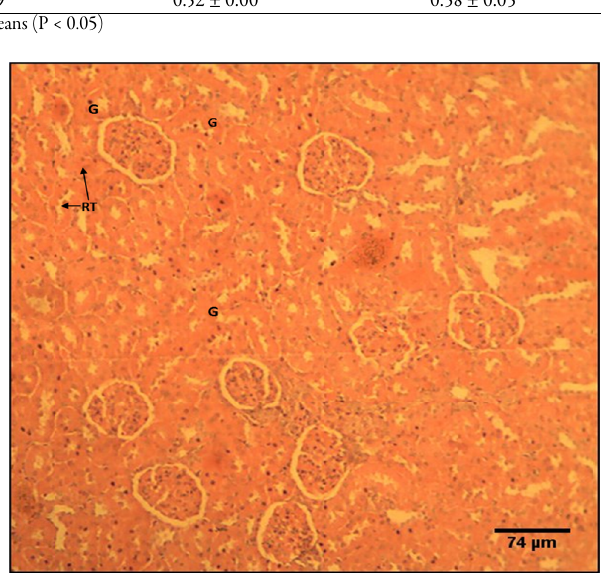
Fig. 1. Histological appearance of liver of rat given 200 1. Histological appearance of liver of rat given 200 1. Histological appearance of liver of rat given 200 body weight of methanol fruit extract of body weight of methanol fruit extract of body weight of methanol fruit extract of Piper guineense for 28 days, showing no obvious lesions. showing no obvious lesions. showing no obvious lesions. Note the central vein (CV), and cords of hepatocytes. (CV), and cords of hepatocytes. (CV), and cords of hepatocytes. H&E × 100